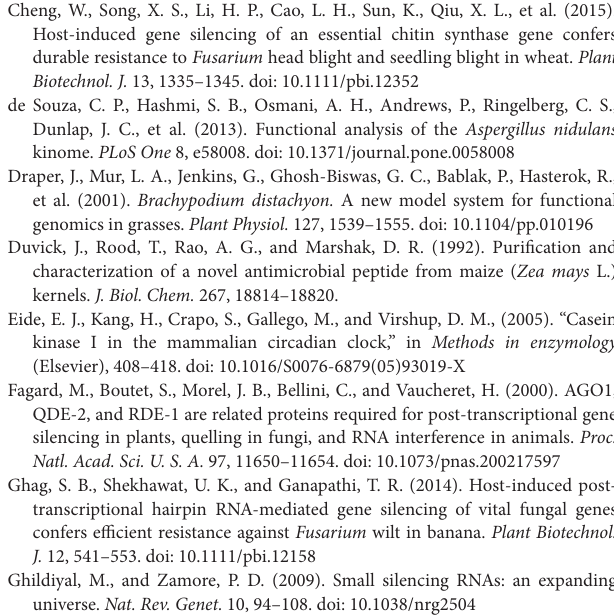
FIGURE S1 | Amino acid sequence alignments of Fg00677 (A) and Fg08731 (B) with other fungal homologs. Amino acid identity (black boxes) and similarity (gray boxes) are shown within the protein kinase domain. The active sites are highlighted with a filled triangle. The ATP binding site is indicated with an arrow. Asterisks indicate the activation loop. Thick black horizontal line indicates the conserved domain of the corresponding protein kinase. FIGURE S2 | The nucleotide sequences of Fg00677 and Fg08731 used for RNAi constructs. The full-length sequences represent the ORFs of Fg00677 (A) and Fg08731 (B). The nucleotides highlighted with bulue color of Fg00677 (A) and Fg08731 (B) were used for RNAi constructs. FIGURE S3 | siRNA detection in transgenic B. distachyon lines. Northern blot analysis of sequence-specific siRNA molecules derived from Fg00677, Fg08731, and CYP51BAC RNAi fragments in the T2 transgenic B. distachyon lines with Fg00677-RNAi, Fg08731-RNAi, CYP51-RNAi constructs. Ethidium bromide- stained rRNA served as loading controls (LC). NTC, non-transformed control. FIGURE S4 | Phenotypes of the Fg00677-RNAi, Fg08731-RNAi, and CYP51- RNAi lines. Transgenic lines compared with the wild-type Bd21-3 at 28 days (A) and at 40 days after sowing (B). Bars, 5 cm. FIGURE S5 | The standard curve generated for the absolute quantification of F. graminearum and B. distachyon. The fragments of beta-tubulin and BdUBC18 were fused to the pMD18-T vector to generate the templates. Threshold cycles were plotted against the quantity of the templates. (A) Standard curve for beta- tubulin generated by using the quantity of the templates (101, 102, 103, 104, 105, 106, 107, 108). (B) Standard curve for BdUBC18 generated by using the quantity of the templates (104, 105, 106, 107, 108). TaBlE S1 | List of primers used in this study. TaBlE S2 | Prediction of off-target transcripts for Fg00677 and